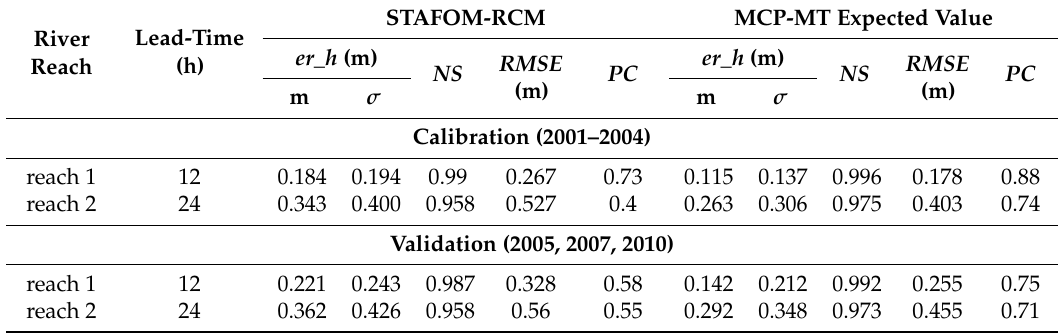
Table 4. As for Table 2, but considering a separated calibration and validation dataset for